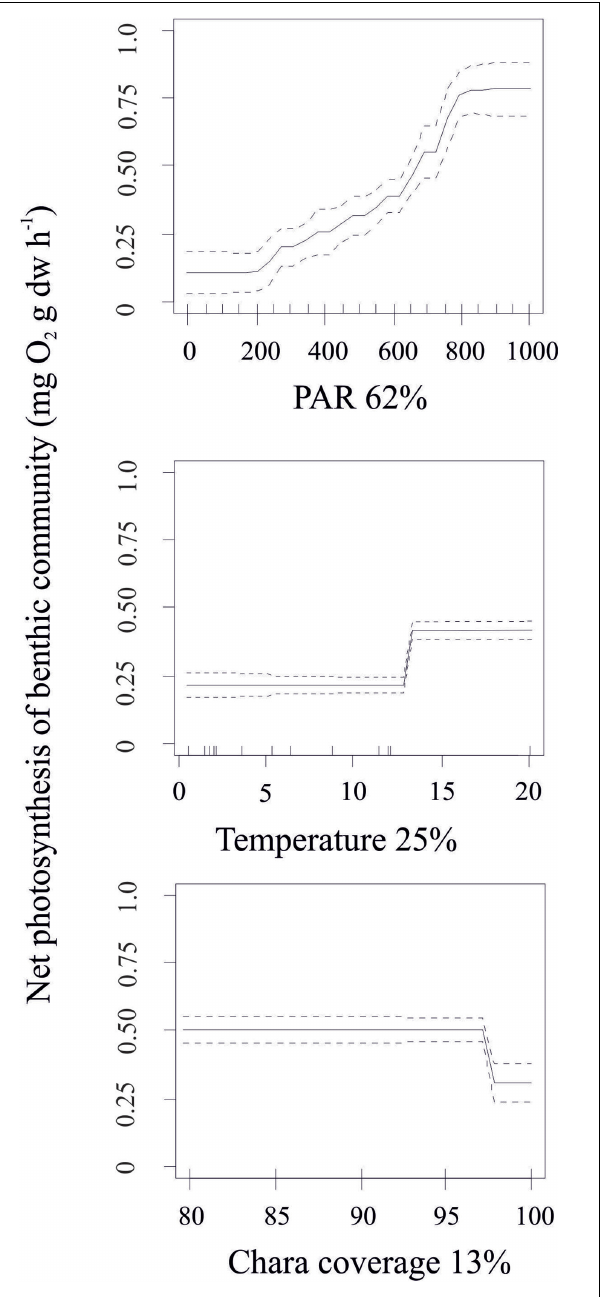
FIGURE 5 | Standardized functional-form relationships ( ± Standard Error) showing the effect of environmental variables on the community production of C. aspera , whilst all other variables are held at their means. The variables are ordered by their relative contribution in the BRT model (shown in%). Upward tickmarks on x -axis show the frequency distribution of data along this axis. See the section of methods for further information on environmental